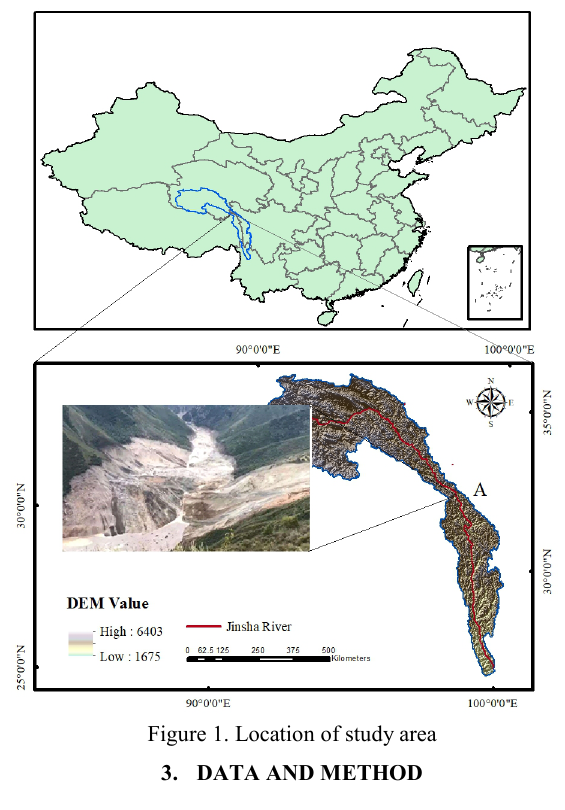
Figure 1. Location of study area